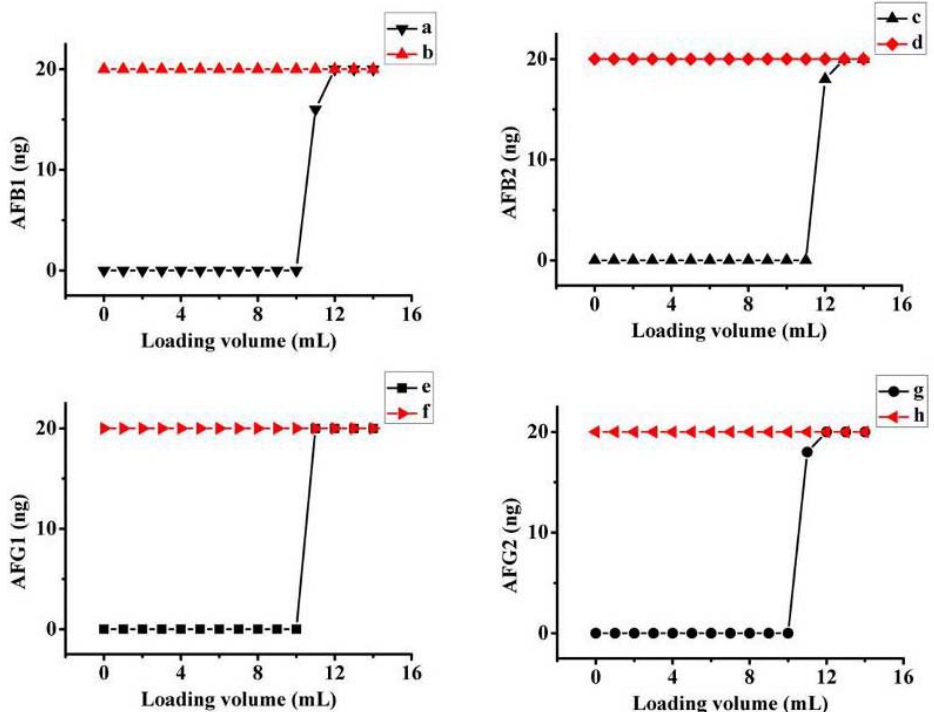
Figure 5. Elution profiles for the continuous loading AFB solution at concentration of 20 ng·mL − 1 onto IAC ( a , c , e , g ) and the blank column with